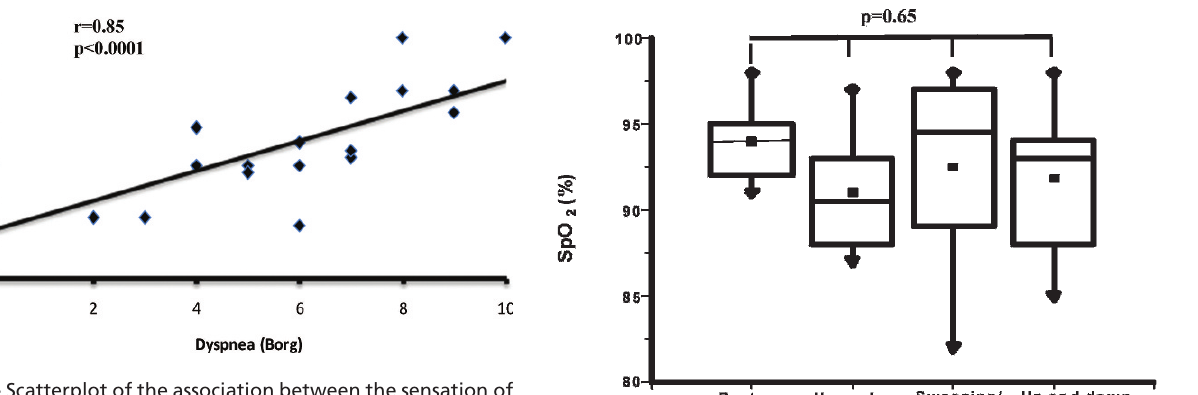
Figure 2 - Scatterplot of the association between the sensation of dyspnea and delta (post-pre) inspiratory capacity. Data are presented as individual inspiratory capacity values.